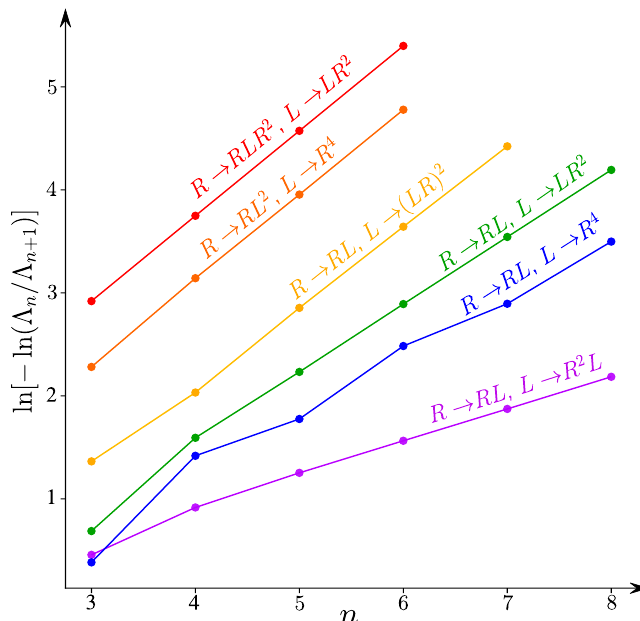
Figure 4: The convergence of the control parameter λ superstable orbit in a given cascade, measured by Λ The data were obtained using the ‘word lifting’ technique applied to the logistic map f λ ( x ) = 1 − λ x 2 . The same procedure applied to the sine map f λ ( x ) = λ sin ( π x ) produces plots indistinguishable by eye. The red and purple (top and bottom) cases correspond to the Clapeyron and Pell cascades